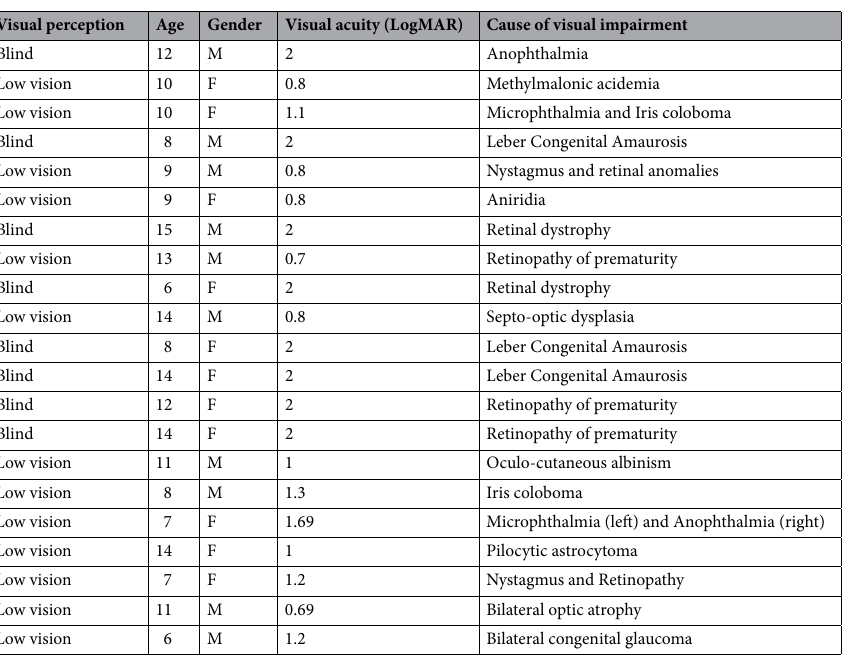
Table 1. Demographical and clinical details of the visually impaired groups. Participants in the visually impaired groups were either congenitally blind (blind group) or congenitally affected by peripheral disabilities causing impoverished visual acuity (low vision group). Visual acuity is reported as LogMAR with values ranging from 0 (normal vision) to complete blindness (2). All participants reported a visual impairment from birth. F, female; M,